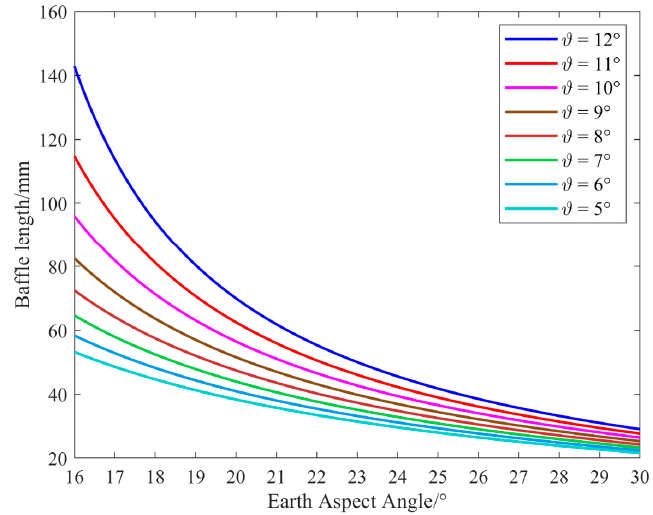
Figure 5. Baffle length with different half-FOV and the earth aspect angle.